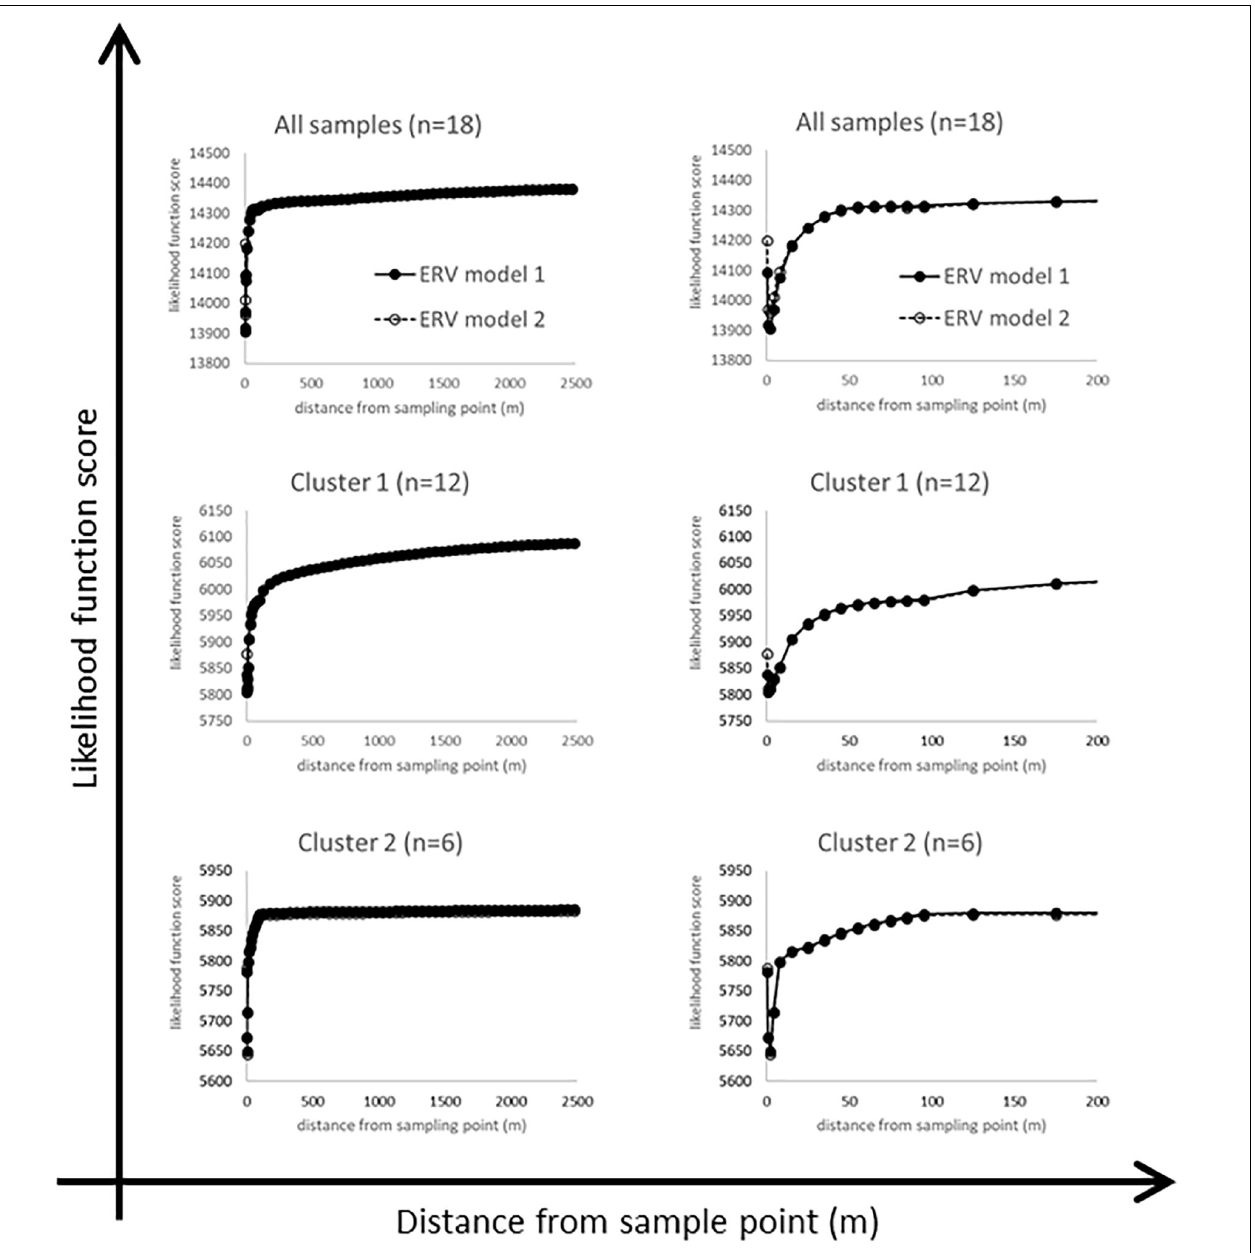
FIGURE 6 | Likelihood function scores for the full dataset and the two clusters, plotted against two different distance scales to show key features (see text for